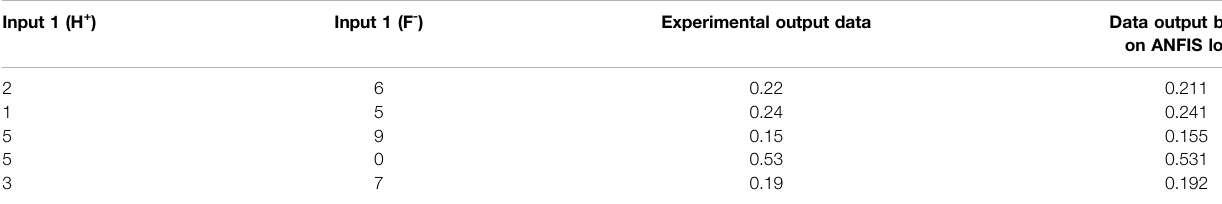
TABLE 4 | Experimental and ANFIS generated outputs.